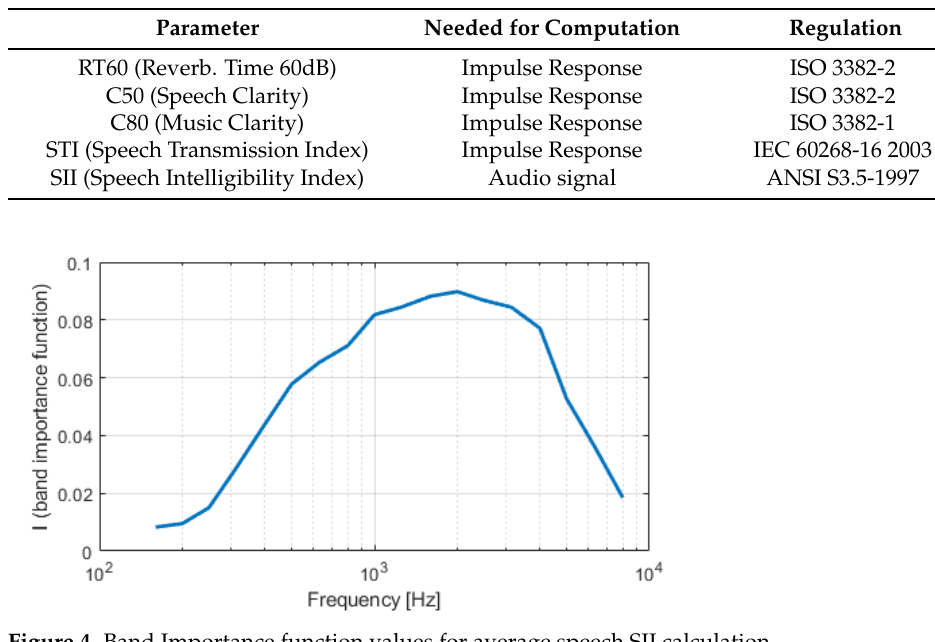
Figure 4. Band Importance function values for average speech SII